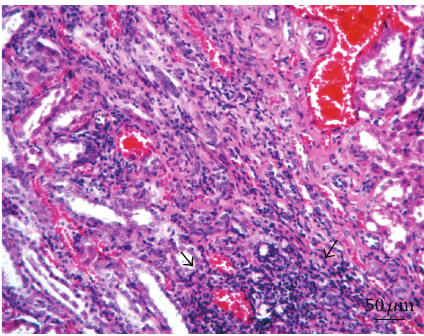
Figure 7: Kidney. Lesion Grade III. Severe interstitial mononuclear cells infiltration (arrows) with fibrosis, necrosis, atrophy, dilation, and degenerative changes of tubular epithelium. Congestive changes in the right upper part of the micrograph. Hematoxylin and eosin.